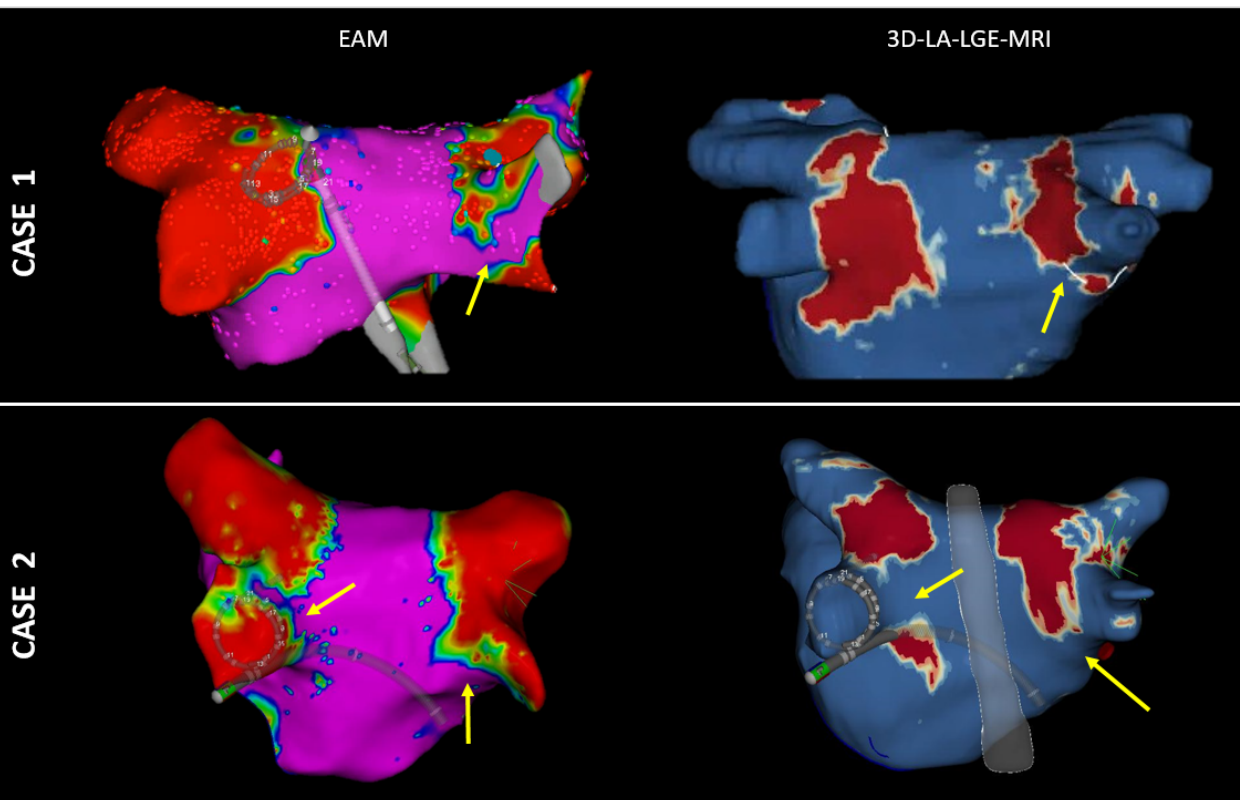
Figure 3. Agreement between EAM voltage map and LGE-MRI gap localisation. From ( left ) to ( right ), voltage map with gaps localised during a repeated ablation intervention. Right, gaps localised at the same region by prior LGE-MRI 3 months post first ablation. Yellow arrows indicate detected EAM gaps and LGE-MRI discontinuities, respectively.